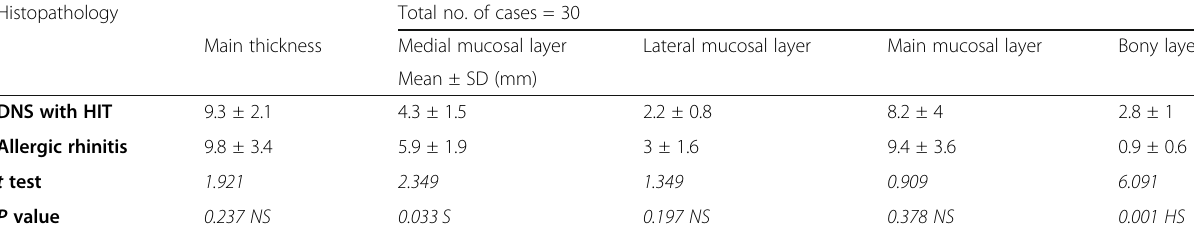
Table 2 Thickness of turbinate ’ s layers in millimeters according to histopathologic studies Histopathology